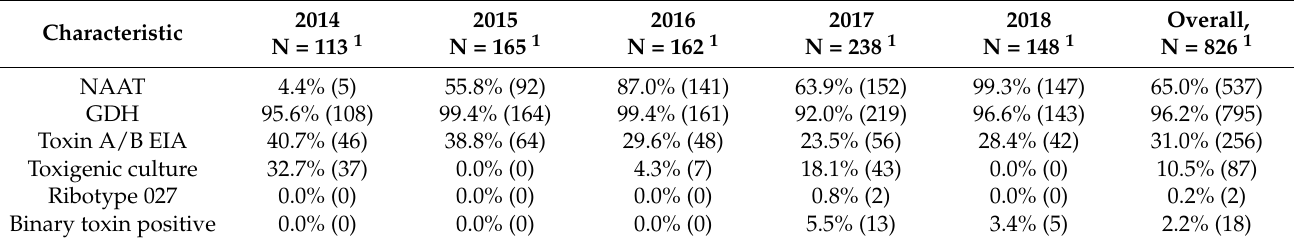
Table 1. Evolution of diagnostic tests over